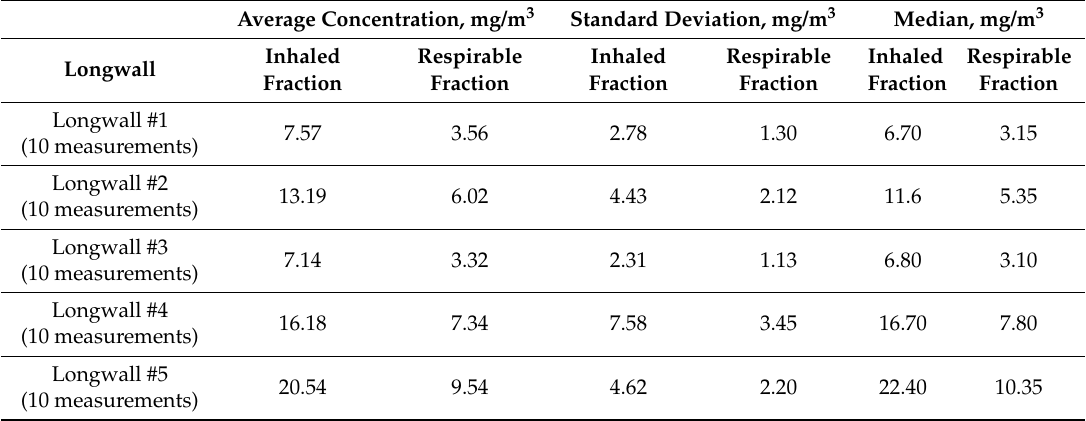
Table 1. A summary of the average values of measurement results for dusting in the longwalls under analysis.